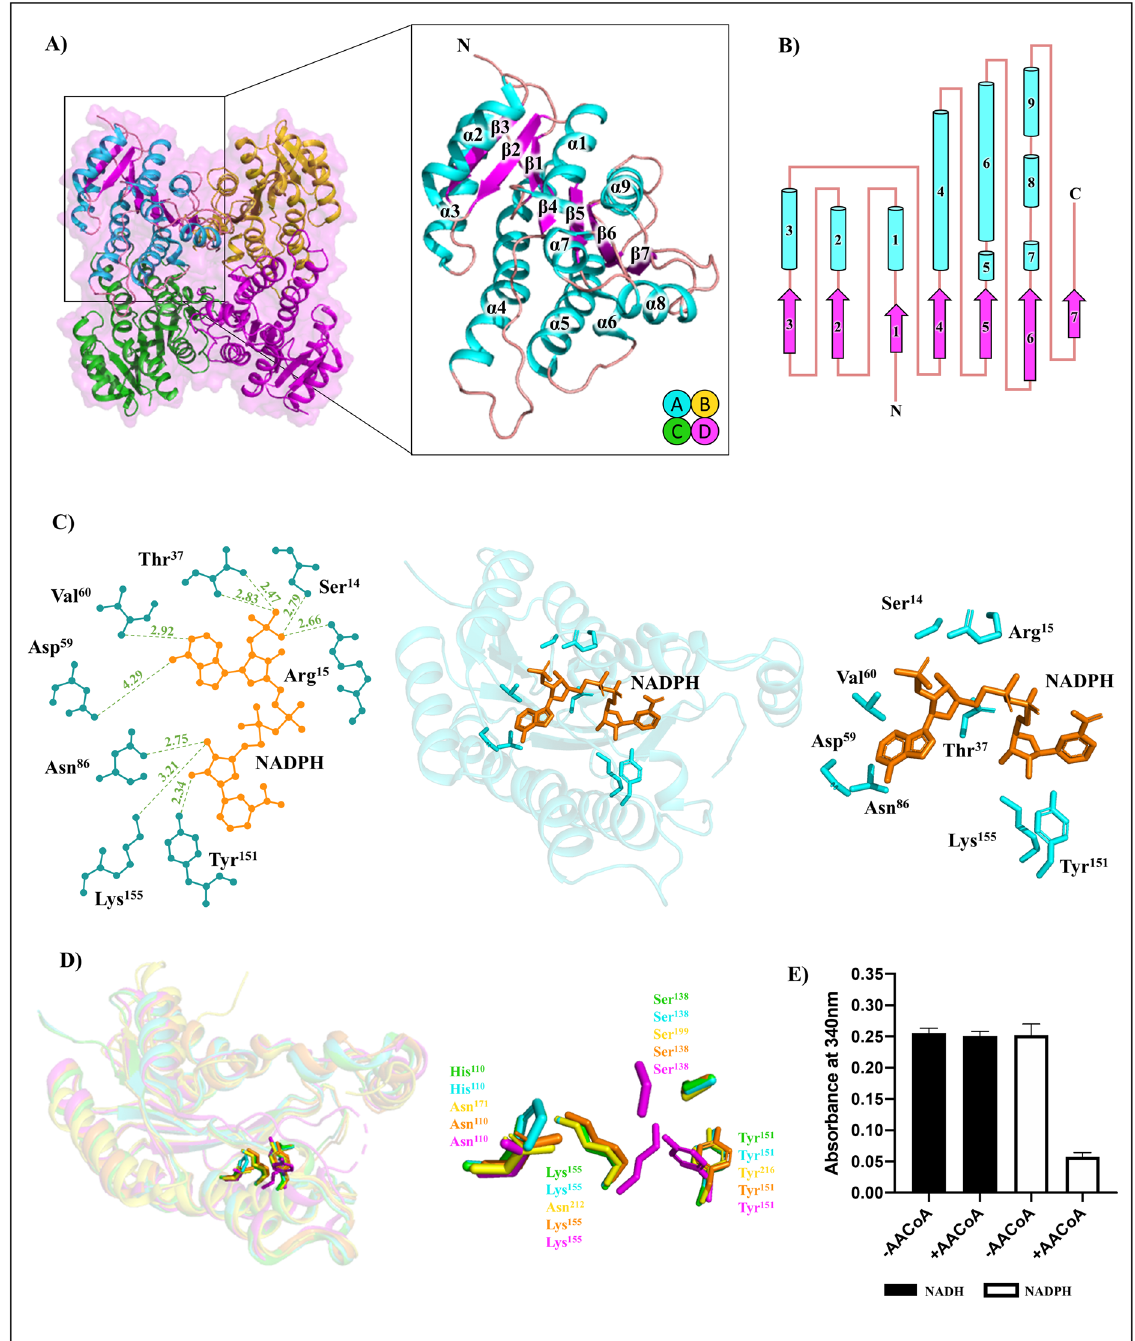
Figure 2. Structure of A. baumannii FabG (ABO11256.2) ( A ) The quaternary assembly and protomer displaying a Rossmann fold within the secondary structure. This model was deposited in the PDB under the code 6UDS. ( B ) Topology diagram of protomer assembly with loops (salmon), α-helices (cyan), and β-sheets (magenta). ( C ) Structure of NADPH (orange) bound FabG. The coenzyme is positioned by several hydrogen bonds (green, distances in ) between NADPH and surrounding residues (cyan). The FabG:NADPH model was deposited in the PDB under the code 6WPR. ( D ) Comparison of FabG active site residues in active and Å inactive conformations. E. coli FabG catalytic residues show conformational changes between the NADP bound ‘active’ (1Q7B/A, orange) and apo ‘inactive’ (1I01/B, magenta) proteins 51,52 . Both apo (PDB: 6UDS/A, green) and NADPH (PDB: 6WPR/A, cyan) structures of A. baumannii FabG show the same ‘active’ residue architecture regardless of coenzyme. Similarly, apo FabG from P. falciparum shows an active arrangement (2C07/A, yellow) 67 . ( E ) FabG enzyme activity assay using acetoacetyl-CoA substrate. All figure images were generated/drawn by the